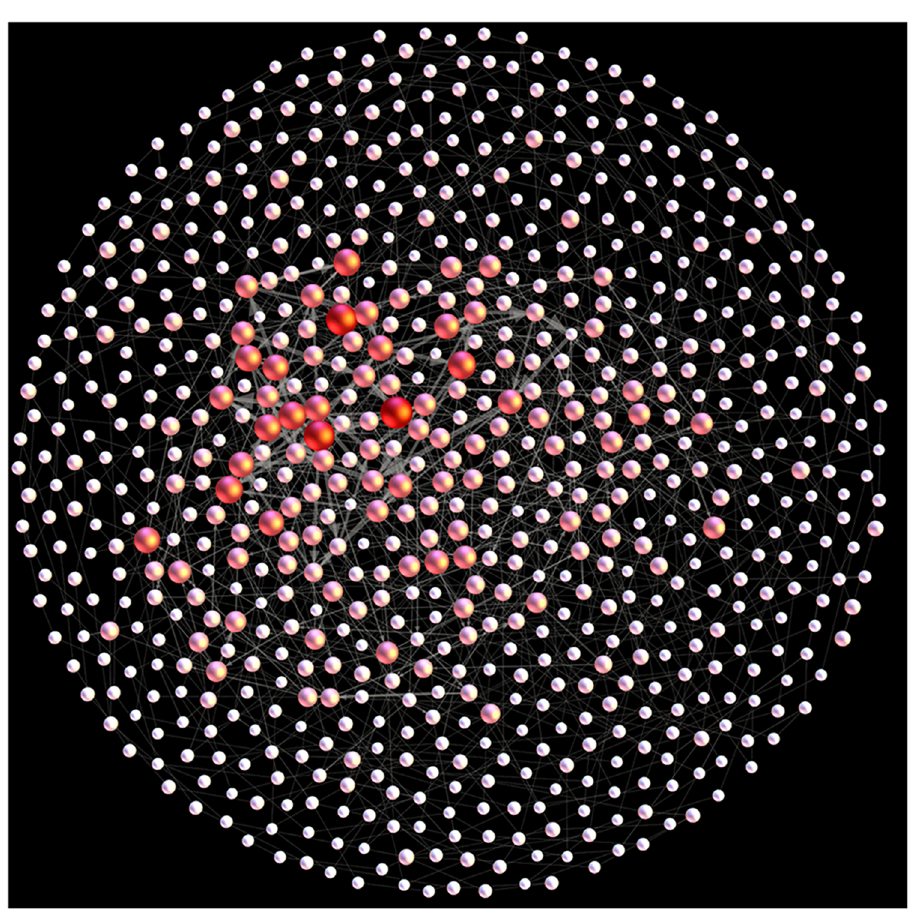
Fig 2. The sentiment mode complex network of online public opinion about "3Q war". The size of a spot represents the strength degree (Eq 7) and the thickness of line represents the size of the weight. The deeper color the node shows, the greater the betweenness centrality (Eq 10) the node